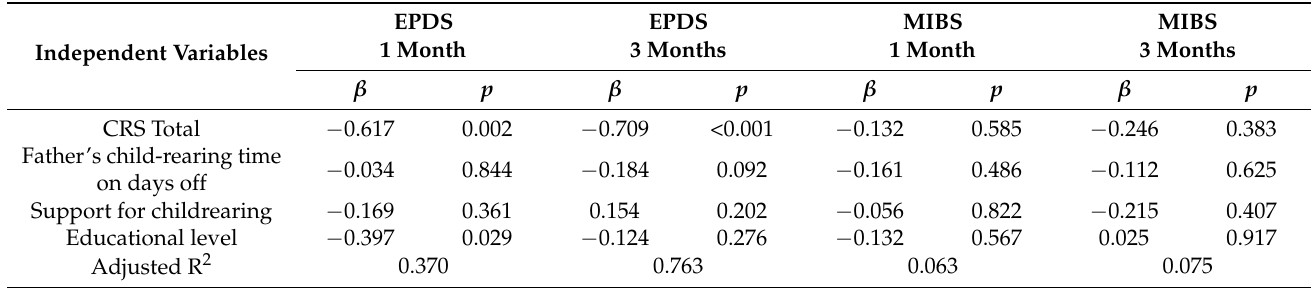
Table 3. Factors associated with mental health at one month and three months after